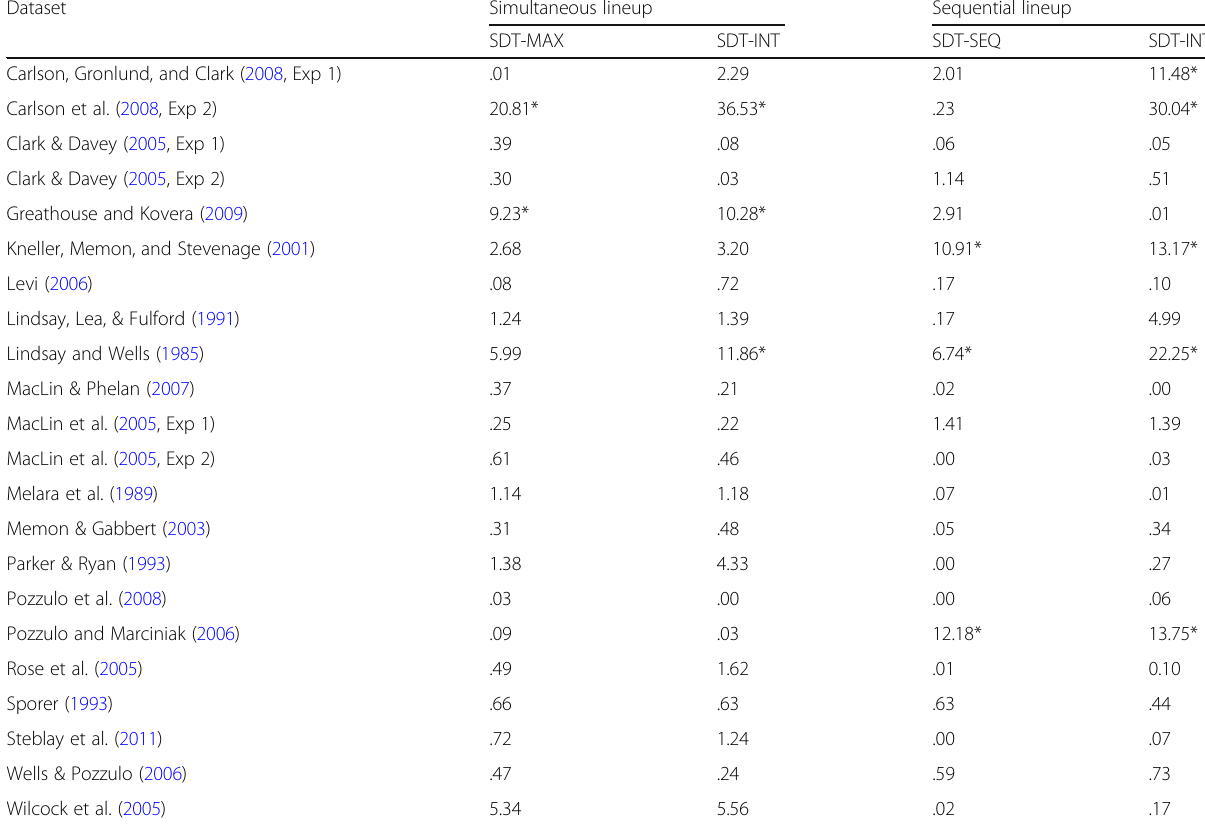
Table 1 χ 2 goodness-of-fit values for each dataset, presentation format and model